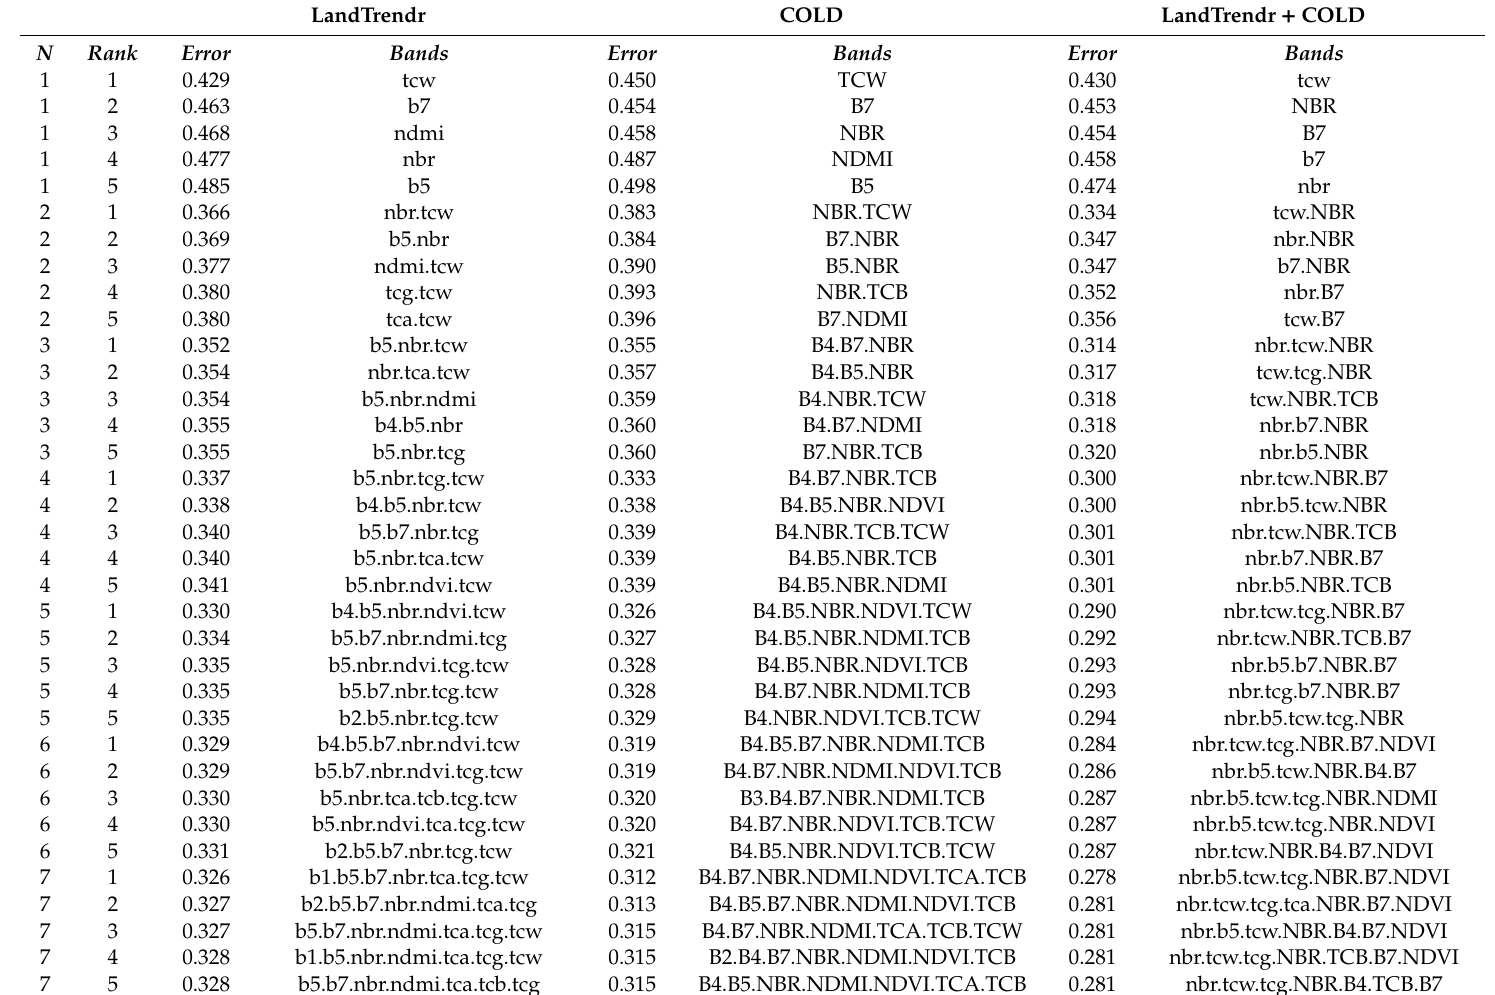
Table 3. Balanced errors and bands used for the top five models for N = 1–7 from LandTrendr, COLD, and the combined modeling